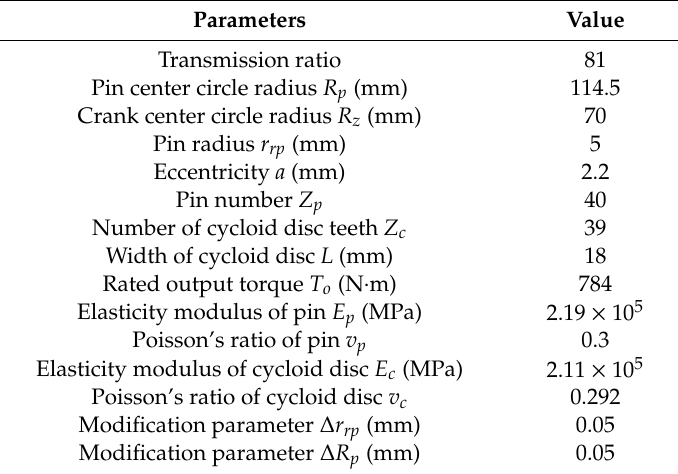
Figure 2. Construction of RV reducer. Table 1. Parameters of RV reducer.